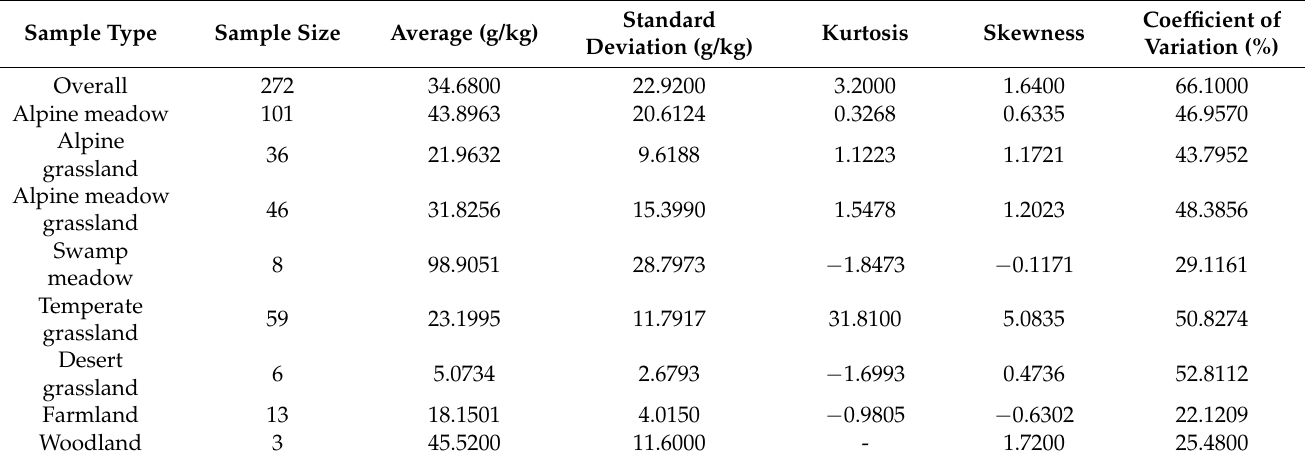
Table 7. SOC content statistics of each vegetation